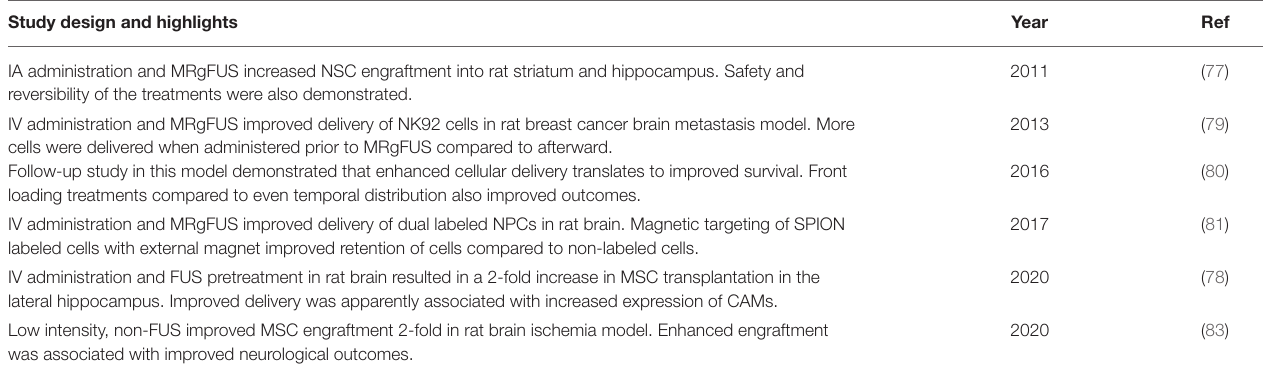
TABLE 2 | Preclinical studies investigating ultrasound for cellular delivery to the brain. Study design and